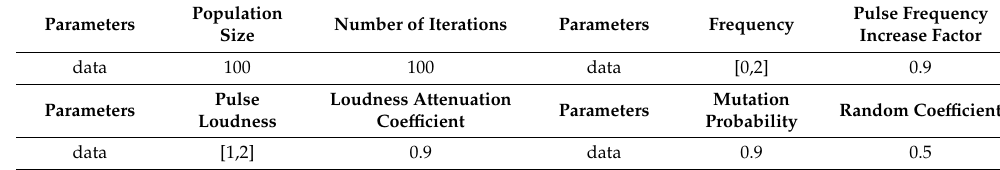
Table A8. Parameters of Bat